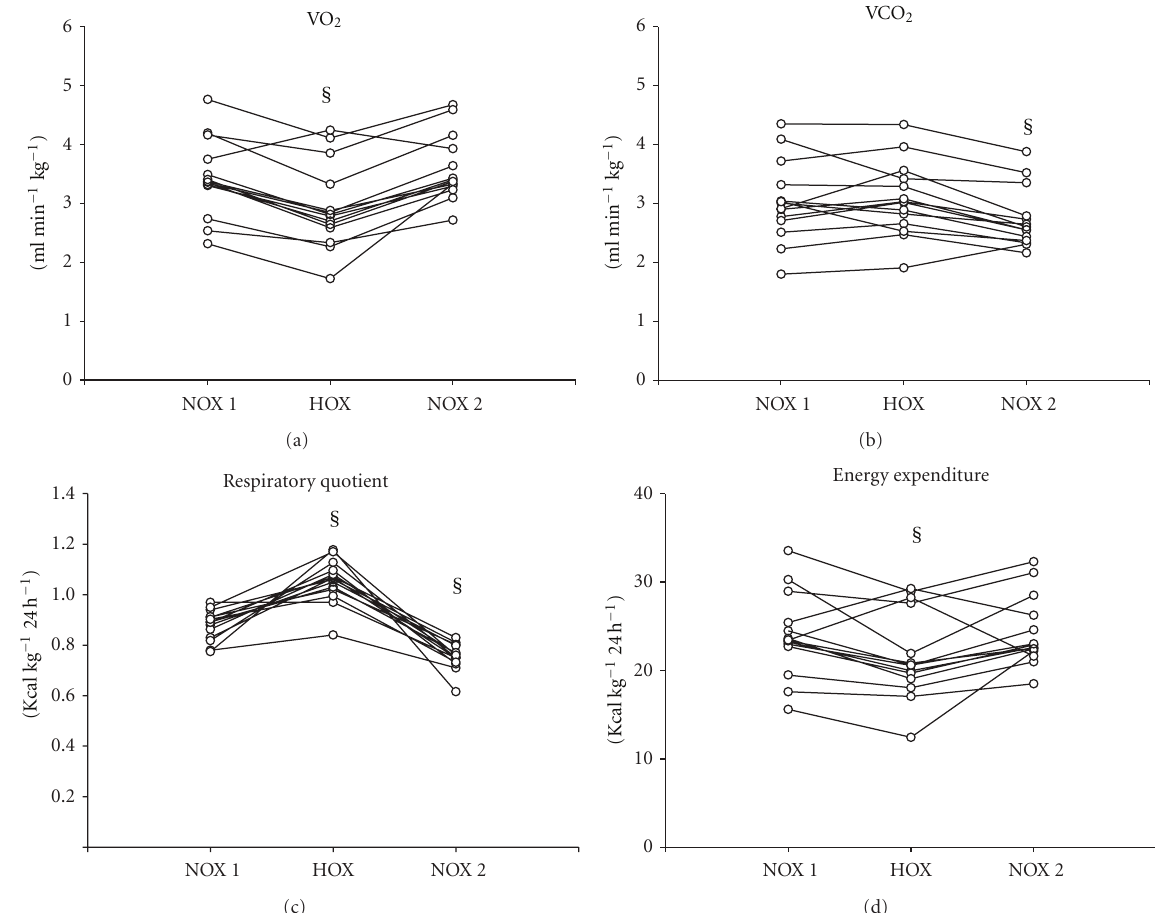
Figure 1: Single-experiment depiction of oxygen consumption (VO 2 ), carbon dioxide production (VCO 2 ), respiratory quotient (RR), and energy expenditure (EE) for the NOX 1 (baseline, FiO 2 0.21), HOX (FiO 2 1.0), and NOX 2 (FiO 2 0.21 again) time points. § P < 0 . 05 time point versus NOX 1.